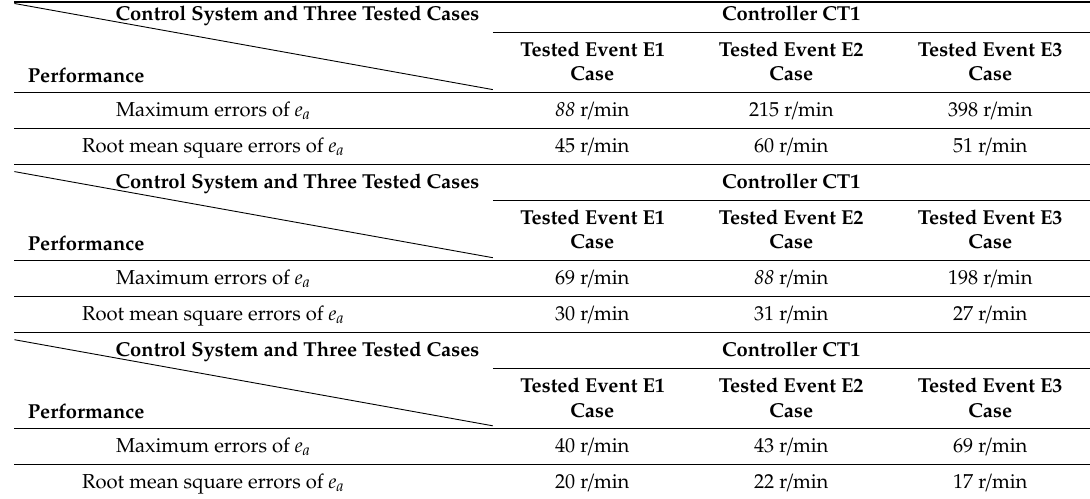
Table 1. Performance comparison of control systems.